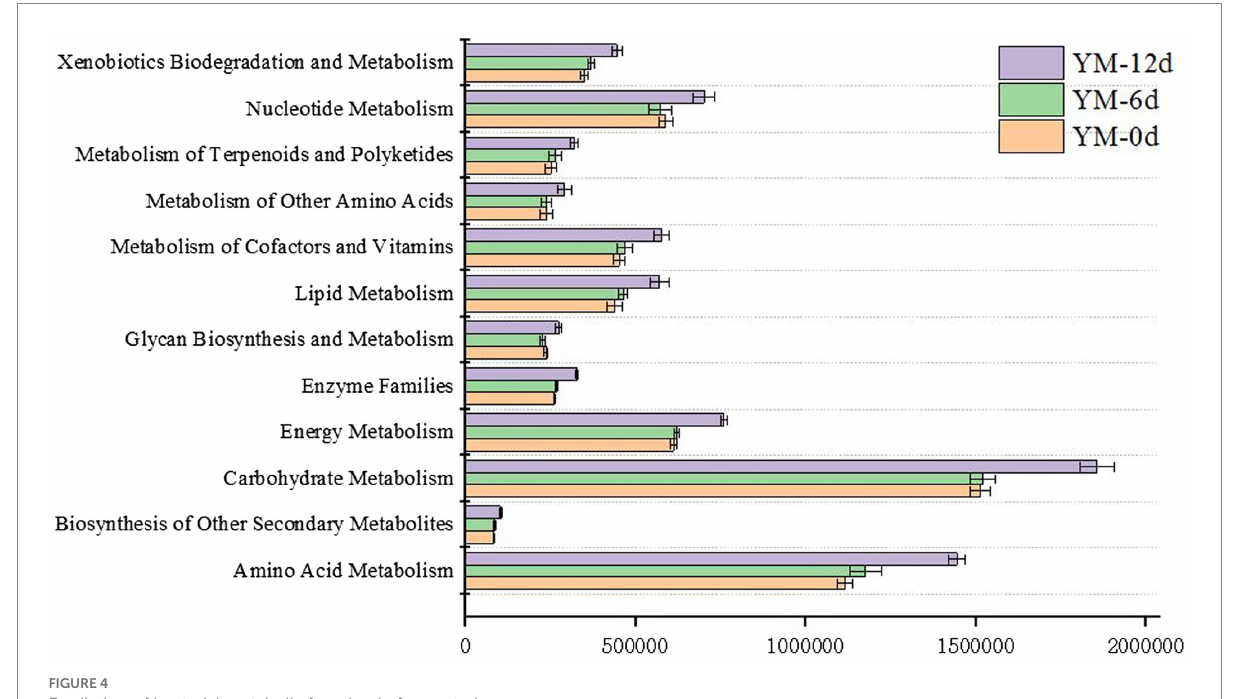
FIGURE 4 Prediction of bacterial metabolic function in fermented